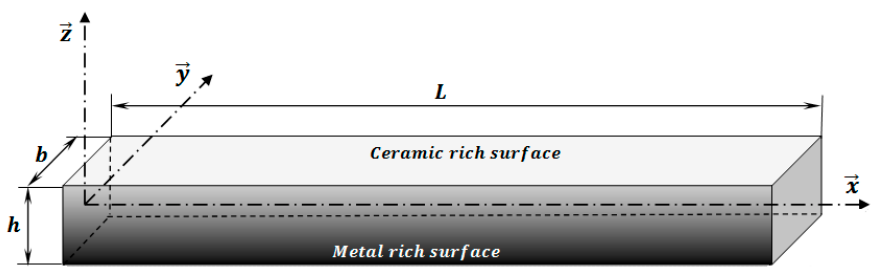
Figure 1. The geometry of the FG beam.